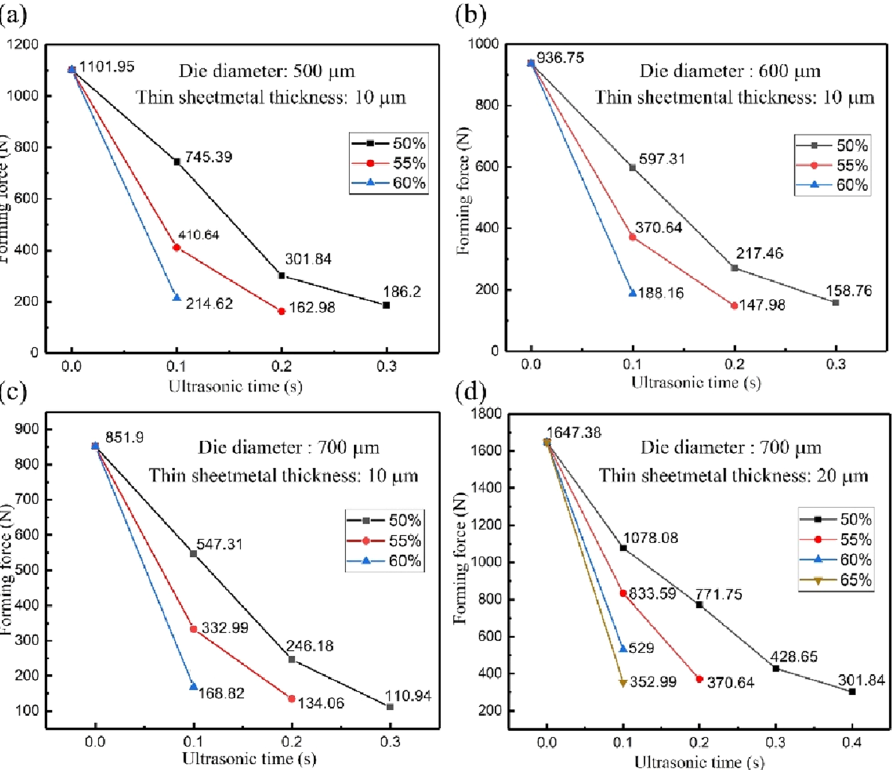
Figure 4. Forming forces obtained for different thicknesses of thin sheet metal and different diameters of dies with different ultrasonic forming parameters. (a) Thin sheetmetal:10 μm, die diameter: 500 μm. (b) Thin